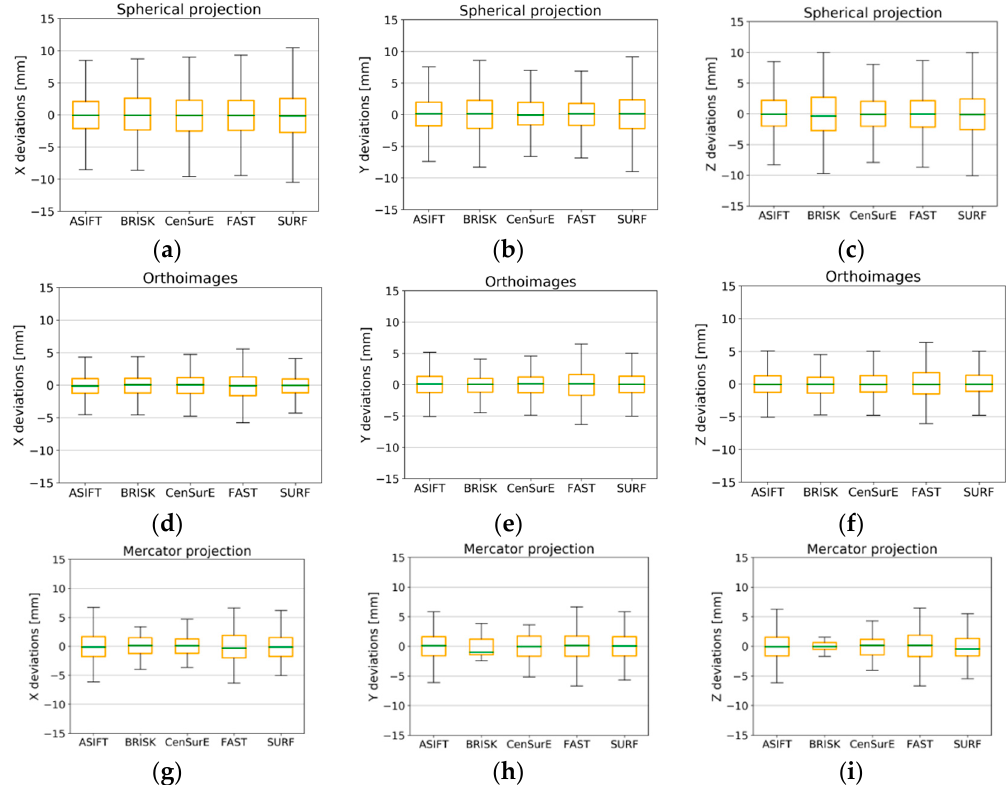
Figure 15. Box plots for the distribution of the deviations of natural control points for all pairs of fully registered scans (without points, sufficient only for the ICP, or unsuitable for registration) for Test Site I. The spherical projection: component—x ( a ), y ( b ), and z ( c ); orthoimages: component—x ( d ), y ( e ), and z ( f ); the Mercator projection: component—x ( g ), y ( h ), and z ( i ).